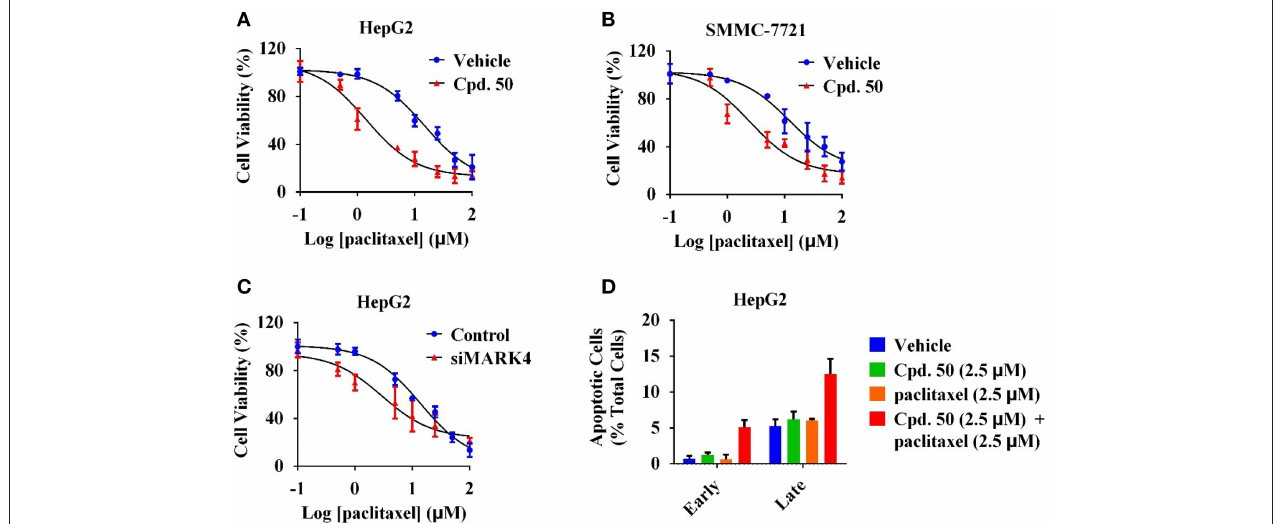
FIGURE 5 | Compound 50 sensitized HCC cells to paclitaxel treatment. (A) Cell viability assay of the varied concentrations of paclitaxel in HepG2 cells with or without the incubation of compound 50 (2.5 µ M). (B) Cell viability assay of the varied concentrations of paclitaxel in SMMC-7721 cells with or without the incubation of compound 50 (2.5 µ M). (C) Cell viability assay of the varied concentrations of paclitaxel in HepG2 cells with the transiently transfection of MARK4-knockdown or control vectors. (D) Cell apoptosis assay of paclitaxel (2.5 µ M) in HepG2 cells with or without the incubation of compound 50 (2.5 µ